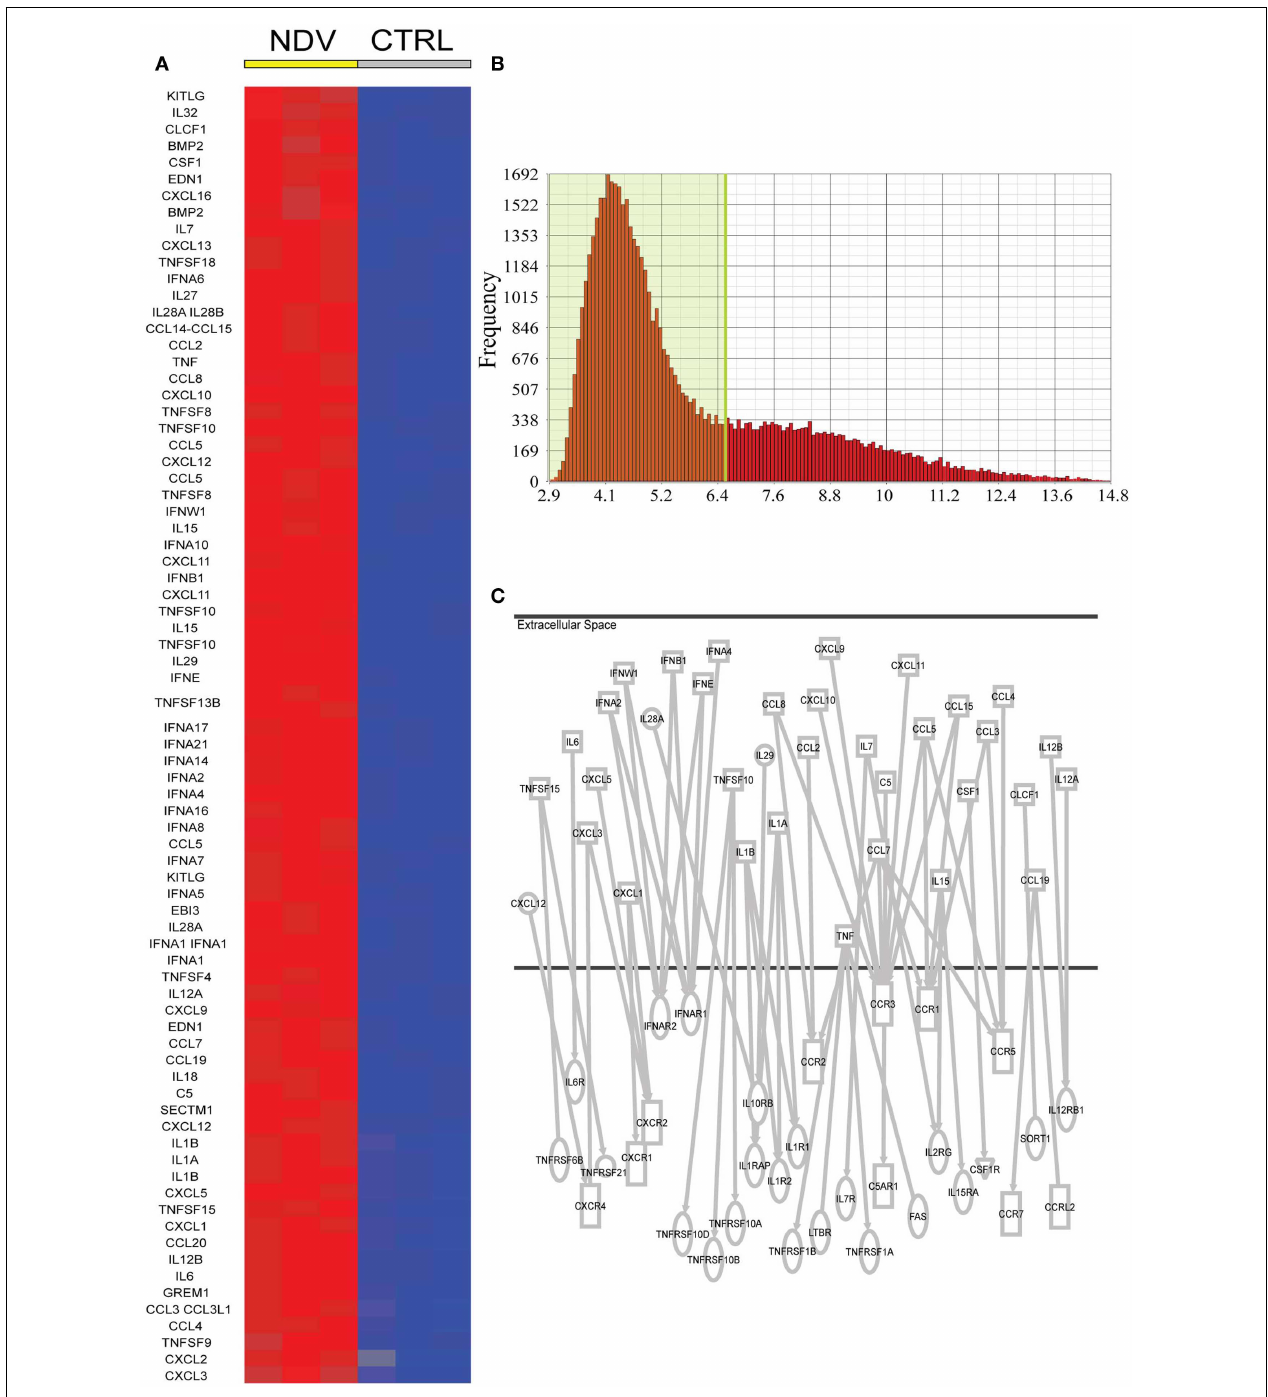
in naive DCs. A cutoff of expression above 6.5 was used to identify potentially expressed cytokine and chemokine receptors. (C) Ingenuity analysis linking induced cytokines/chemokines to receptor genes also expressed in